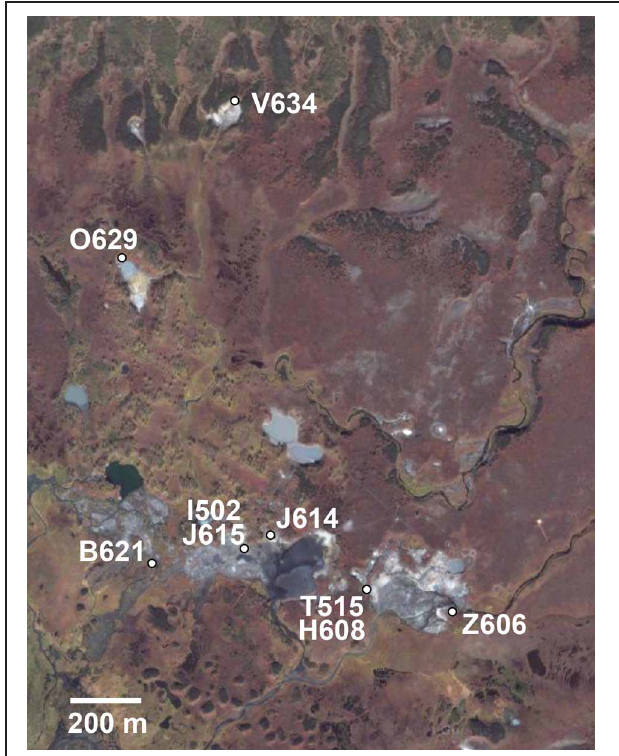
FIGURE 1 | Location of sample sites in the Uzon Caldera for 106 T. uzonensis strains used in this study. Hot spring positions and abbreviations ( Table 1 ) were overlaid on the satellite image. Image © 2009 Google—Imagery © 2009 DigitalGlobe, GeoEye, Map data © 2009 Geocentre